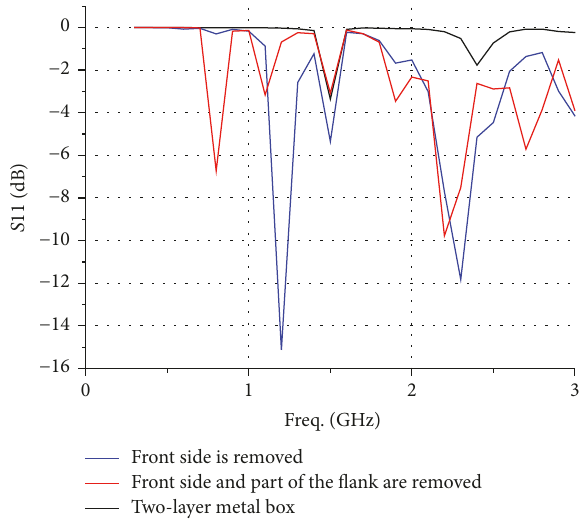
Figure 16: Return loss curves of antennas with three different metallic shells.